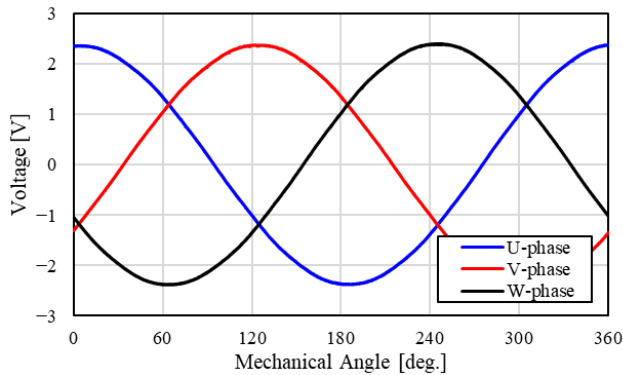
Figure 21. Back e.m.f. waveform at rotating speed of 1000 r/min.